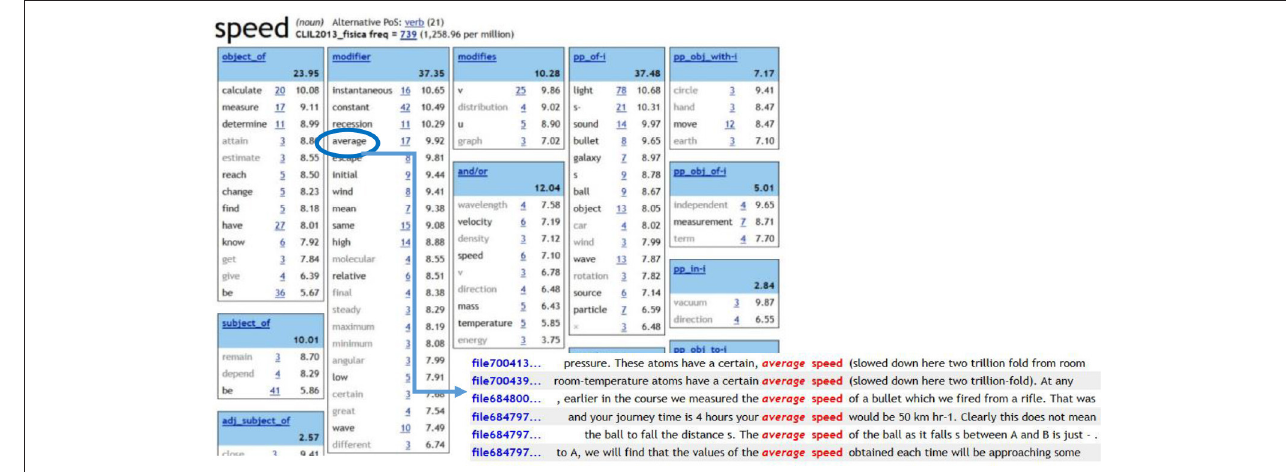
FIGURE 3 | Word sketch and KWIC of speed (from Sketch Engine).